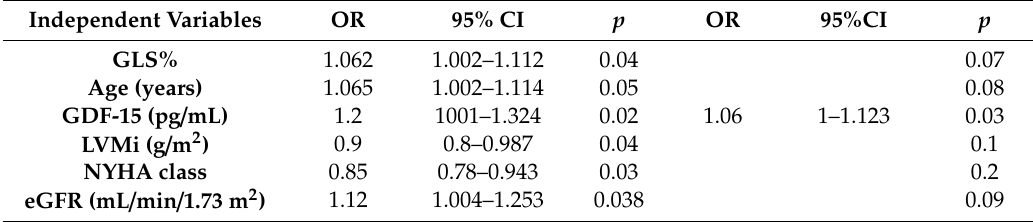
Table 3. Logistic uni- and multi-variable regression analysis with a Katz score < 5 as the dependent variable. Independent